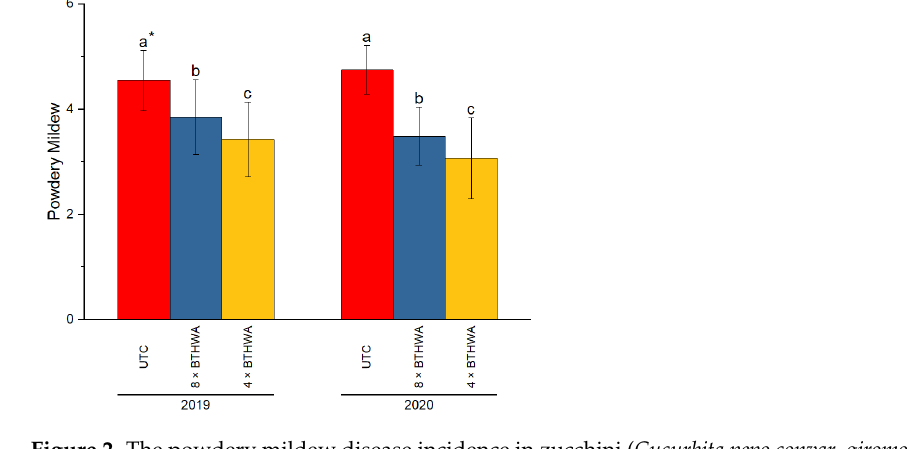
Figure 2. The powdery mildew disease incidence in zucchini ( Cucurbita pepo convar. giromontiina ) was treated in two variants with BTHWA in 2019 and 2020. Significant differences found between the results for the plants treated in the same variant in respective years (treatments × years), * means followed by different letters indicate significant difference at p < 0.05 according to Tukey’s HSD ( n = 20). UTC — Untreated Control plants that were not treated with BTHWA, 8 × BTHWA — plants that were treated with BTHWA eight times, 4 × BTHWA — plants that were treated with BTHWA four times.